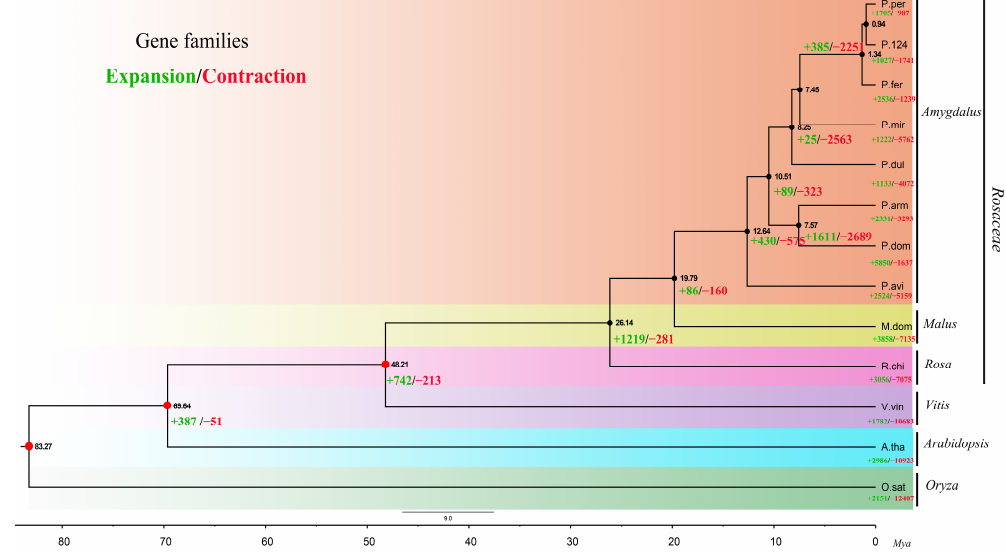
Figure 5. Dated phylogeny for 13 plant species with O. sativa as an outgroup. The timescale (Mya: Millions of years ago) is shown at the bottom. The red points in some nodes represent fossil calibration points and the black points in other nodes represent predicted fossil calibration points. Three constraints obtained from the TIMETREE website were used for time calibrations: (1) 115–308 Mya for the monocot-dicot split; (2) 98–117 Mya for the A. thaliana - V. vinifera split; (3) 107–135 Mya for the V. vinifera - R. chinensis split. The predicted divergence time was showed beside the points. The numbers in red and green font on each branch and node represent the quantity of expanded (+) or contracted ( − ) orthologous clusters after the corresponding speciation respectively. The 13 species were classified into six genera ( Prunoideae , Malus , Rosa , Vitis , Arabidopsis , Oryza ), Prunoideae , Malus, and Rosa belong to Rosaceae. Table 5. Functional annotation of the significantly overrepresented and underrepresented gene families in ‘124 pan’. Gene Families KEGG 1 Terms Input No. Background No. p -Value Corrected p -Value